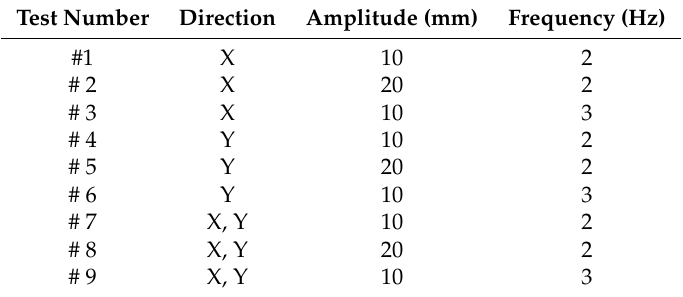
Table 2. Experiment scheme under sinusoidal